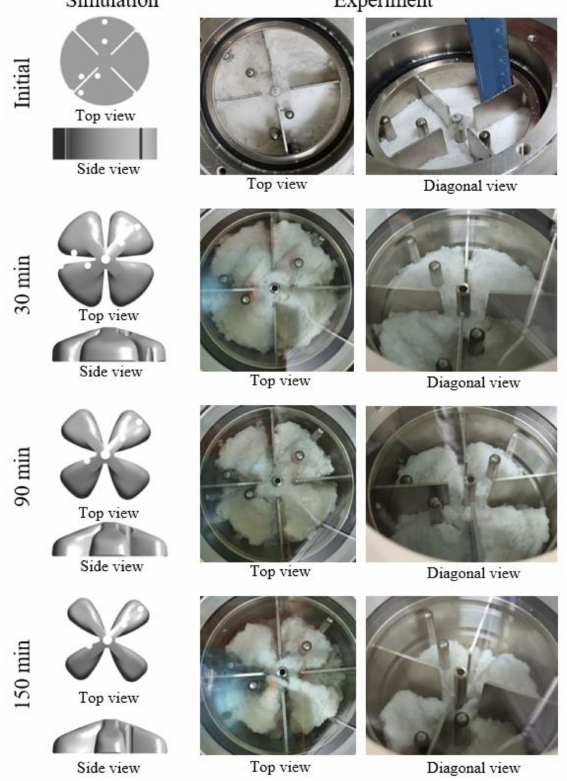
Figure 5. Variation of the shape of solid ammonium carbamate when the reactor is heated.